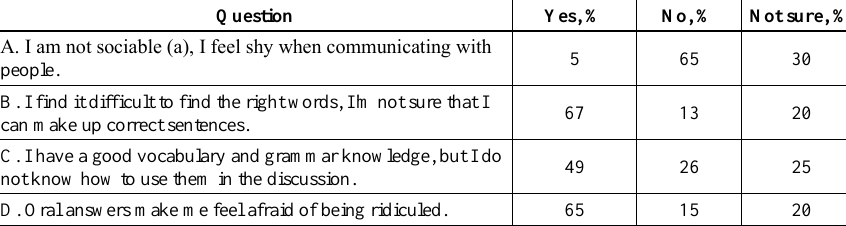
Table 5. State of students when communicating with